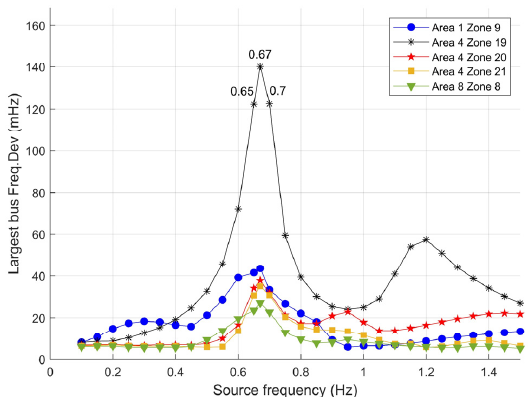
Figure 7. Location dimension scanning results of the forced oscillation source with the top five frequency deviations.